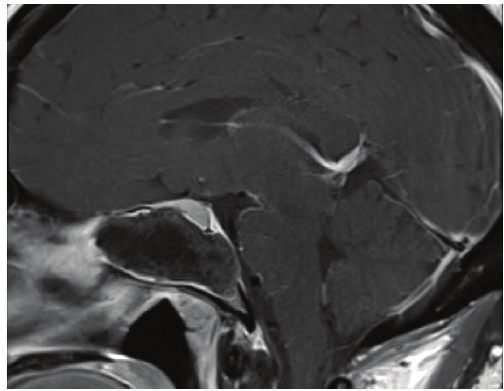
Figure 2: MRI of brain with sagittal view demonstrating expansile lesion centered in sphenoid sinus. The area with the signal void represents fungal debris. There is noticeable mass effect upon the sella with superior deviation of the pituitary gland and kinking of the